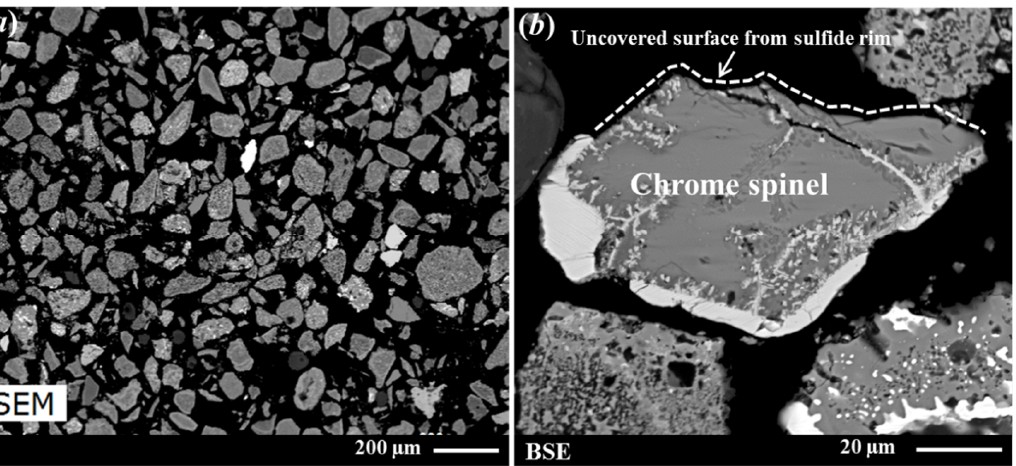
Figure 10. ( a ) SEM BSE image of the sulphidised sample after grinding; ( b ) BSE image of a sul- phidised chrome spinel grain after grinding showing a partially removed sulphide rim. This sample is the feed for Flotation Test‒4.